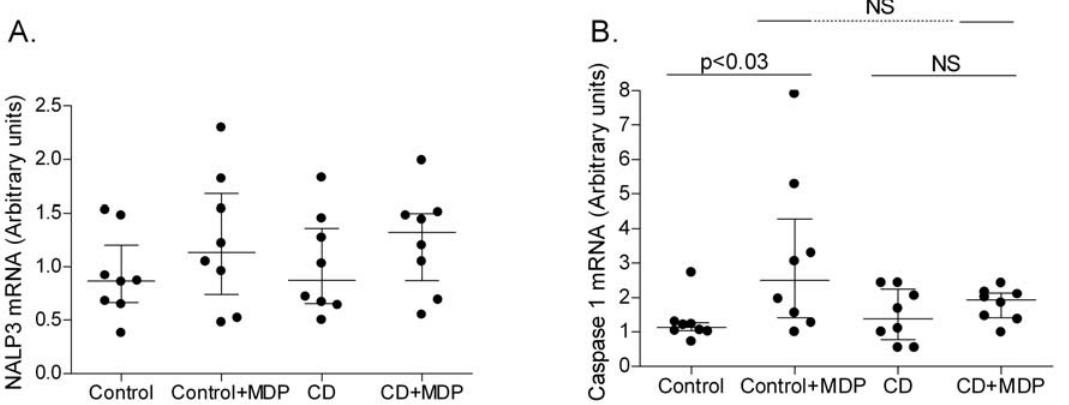
Figure 3. MDP-induced mRNA expression of NALP3 and caspase 1. RT-qPCR of mRNA of inflammasome member NALP3 (A) and caspase 1 (B). Arbitrary units. Isolated monocytes were stimulated for 24 hours. Stimulation with MDP increased the level of caspase 1 expression in control cells (p , 0.03), whereas such an increase was not found in CD monocytes.